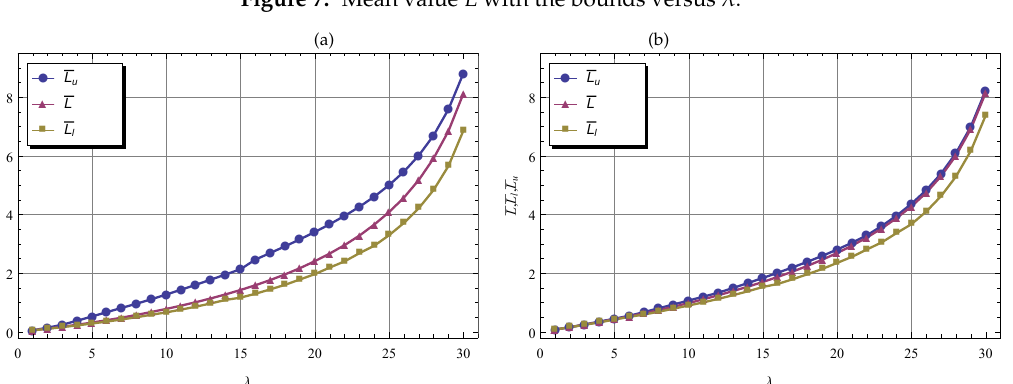
Figure 7. Mean value ¯ L with the bounds versus λ .